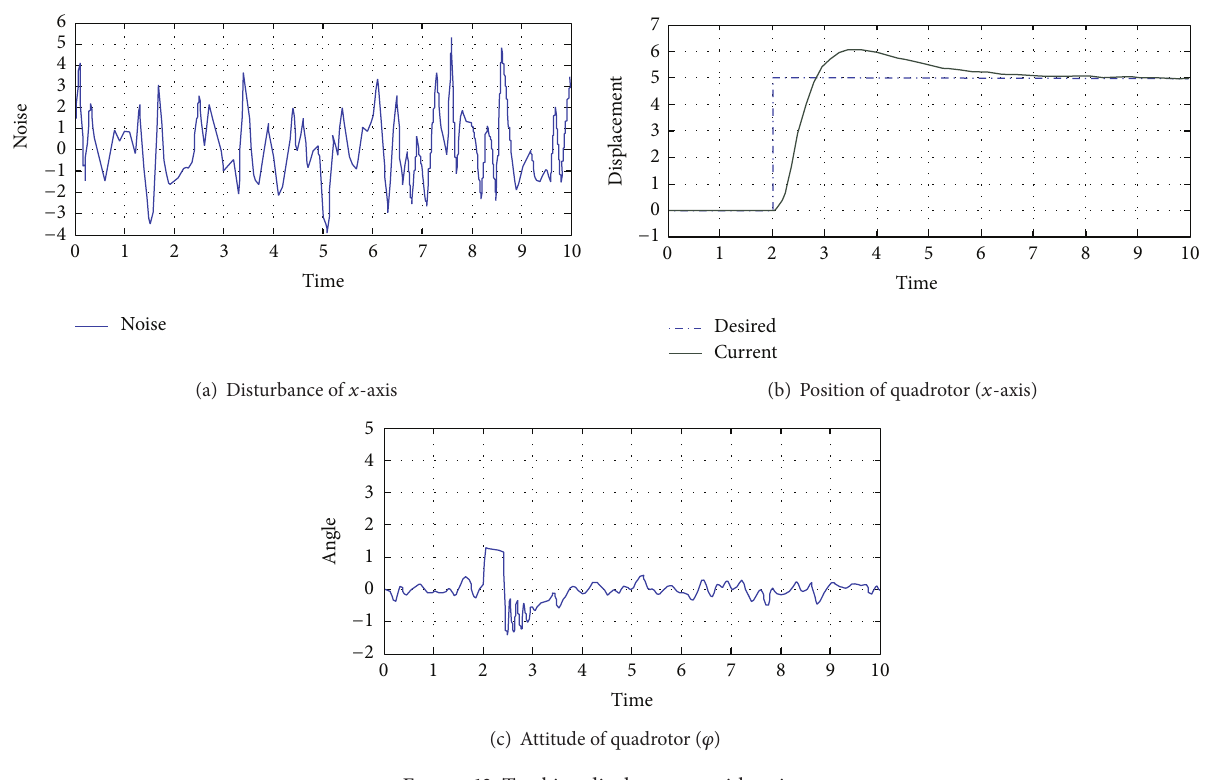
Figure 13: Tracking displacement with noise.